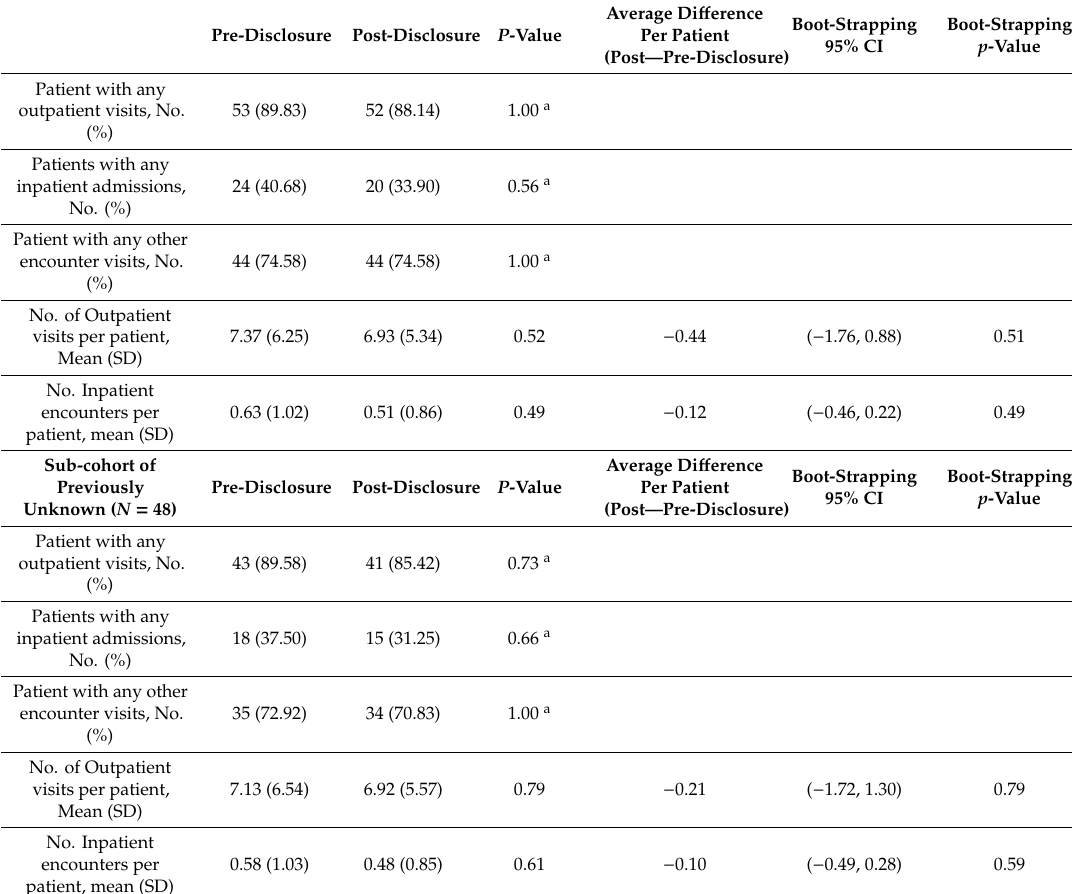
Table 2. Healthcare utilization in the pre- and post-disclosure of